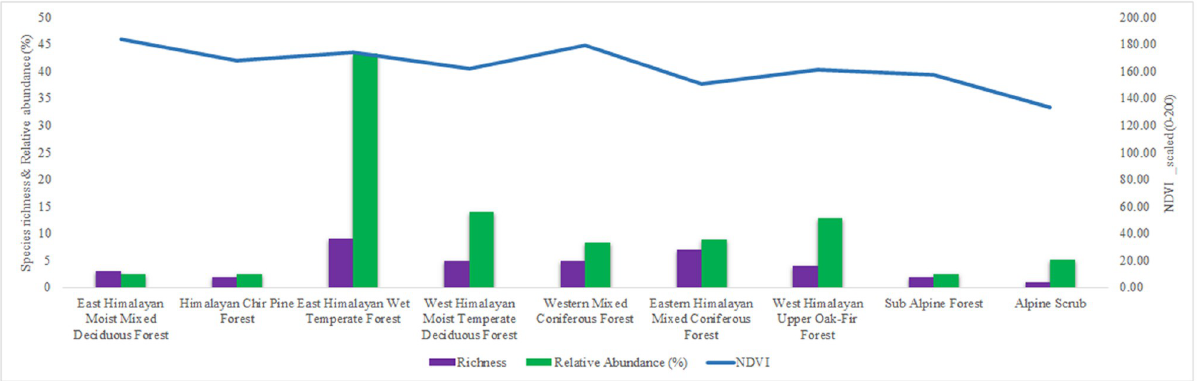
Fig 16. Species richness and relative abundance of Psyra from 9 major habitat types and their average Normalized Difference Vegetation Index (NDVI) values sampled in Indian Himalaya during sampling period of 2010–2012 and